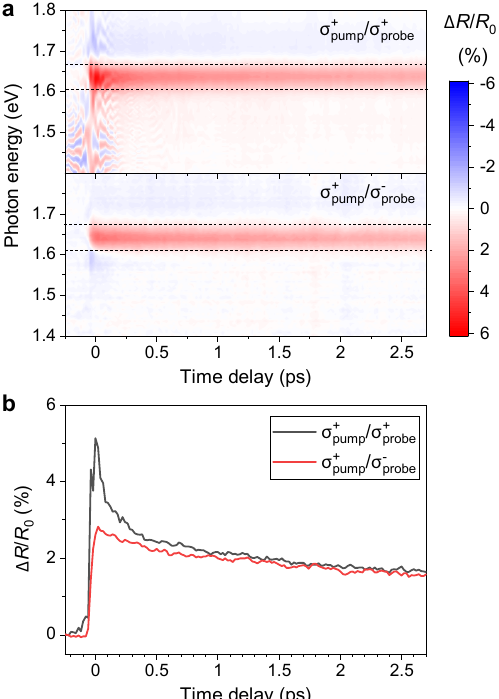
Figure 2. ( a ) Evolution of transient reflectivity for σ + pump / σ + of pulses (upper panel) compared to an opposite combination of polarizations σ + pump / σ − panel). Both measurements are performed with the pump fluence of 65 µ J/cm 2 . ( b ) Time evolution of the transient reflectivity spectrally integrated over the exciton resonance (region marked by dashed lines in ( a